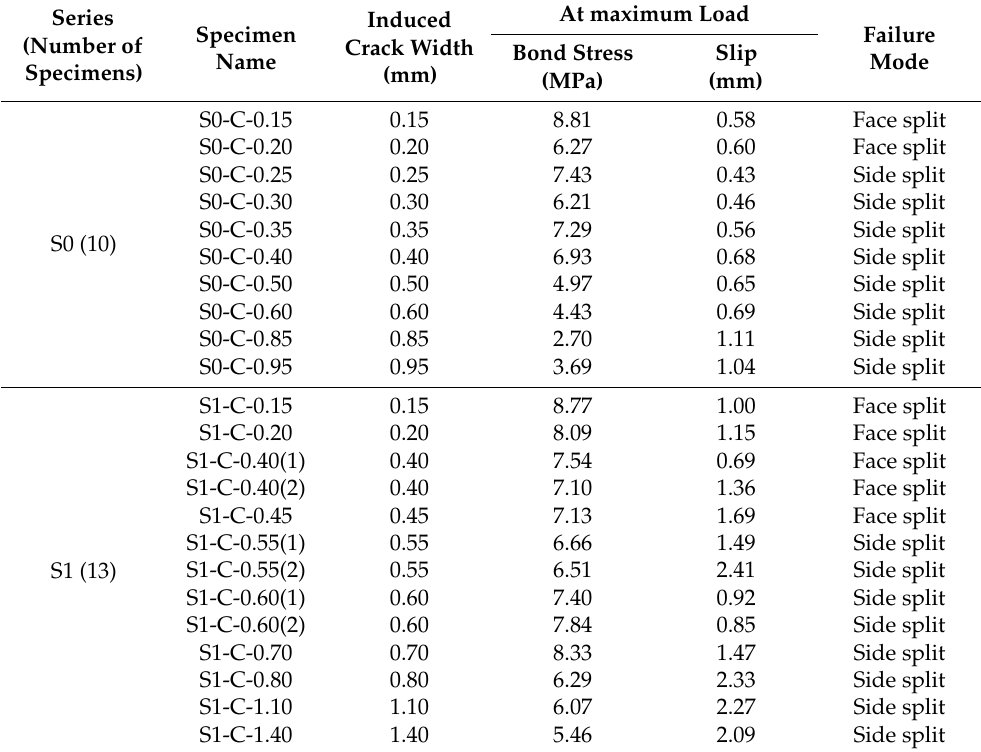
Table 2. List of test results.